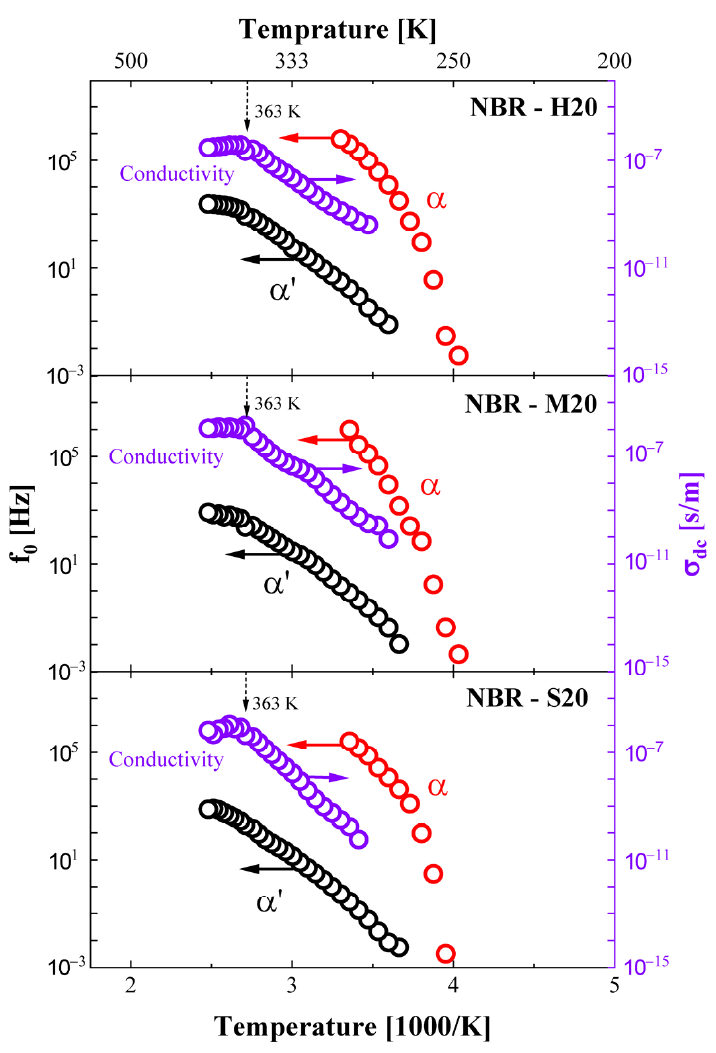
Figure 7. The variation of the central frequency for each relaxation process and DC conductivity as a function of reciprocal temperature for NBR-H20, NBR-M20, and NBR-S20. The black circles indicate the α′ process, and the violet and red circles indicate the DC conductivity and α process, respectively.